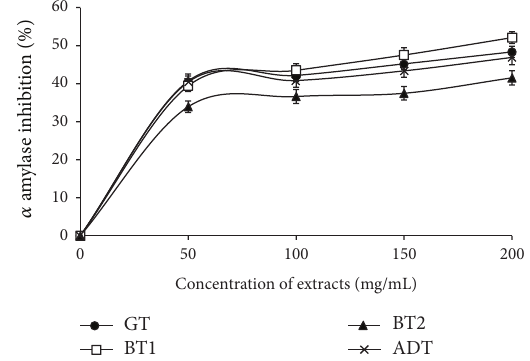
Figure 4: Inhibition of 𝛼 -amylase by aqueous extracts from some commercially available teas. GT: Green tea; BT: Black tea; ADT: antidiabetes tea. Figure 5: Inhibition of 𝛼 -glucosidase by aqueous extracts from some commercially available teas. GT: Green tea; BT: Black tea; ADT: antidiabetes